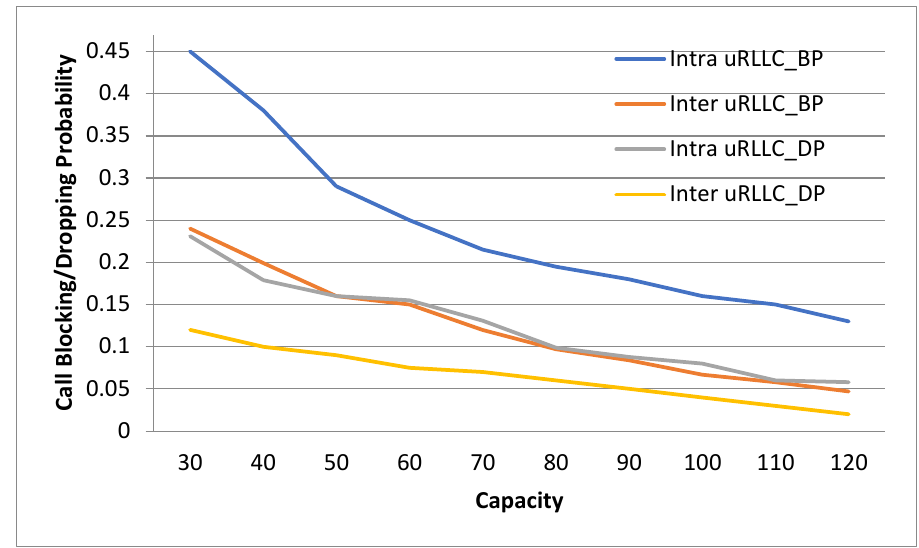
Figure 4. Since the uRLLC slice accommodated calls from extra slices during inter-slice handover, the slice did not have adequate bandwidth dedicated for uRLLC calls, resulting in more calls being blocked and missed during inter-slice handover.